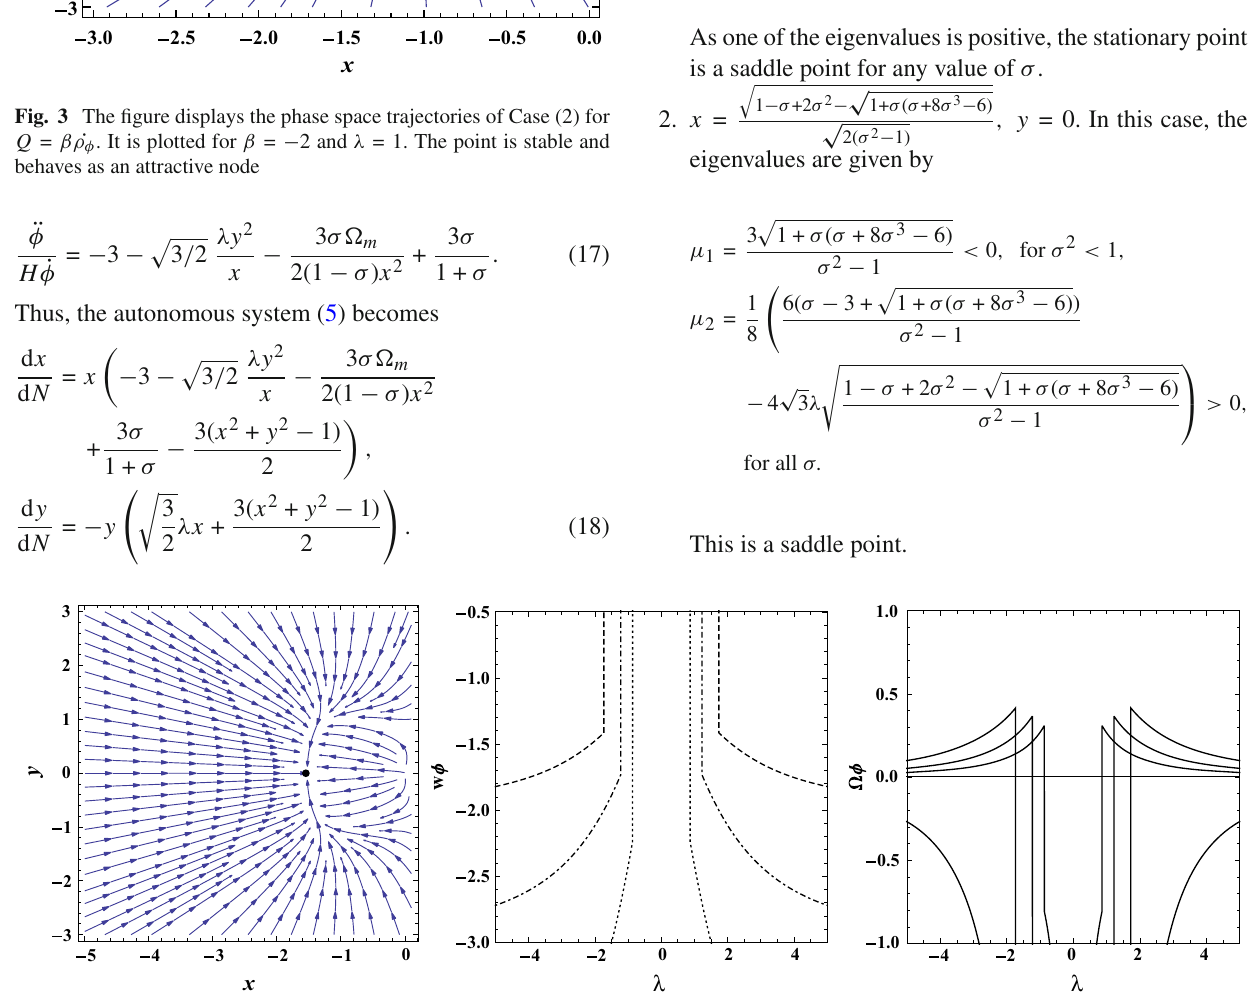
β = − 0 . 5 , − 2 , − 3 and − 5, respectively. The values of λ below the horizontal line are not accepted. This is a stable point and acts as an attractive